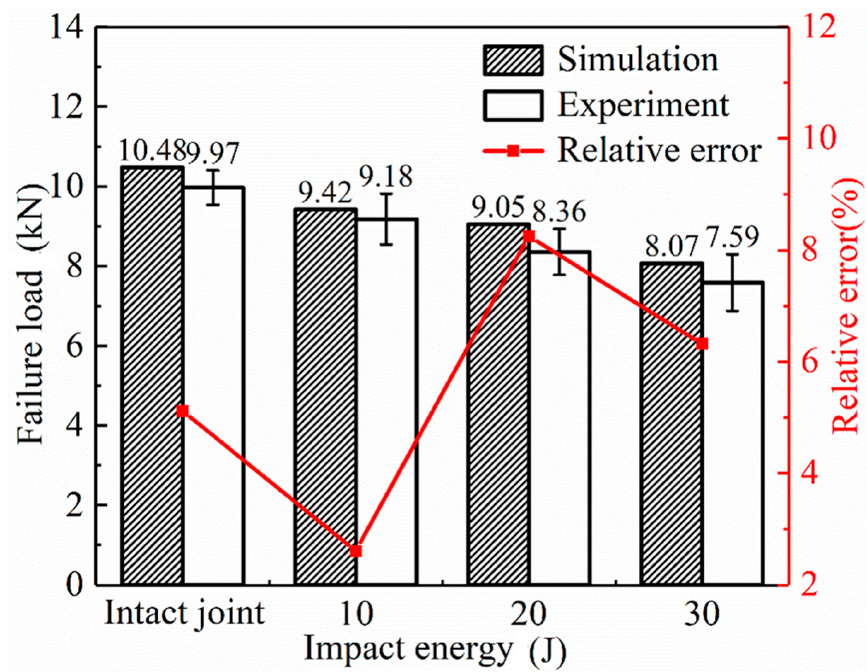
Figure 17. The failure loads of the SLJs under different impact energies.